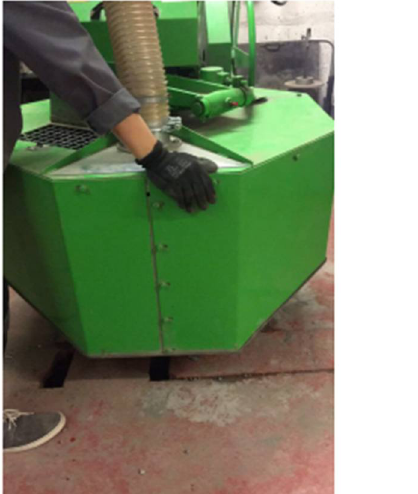
Figure 5. Concrete mixer ( left ); concrete slump test ( right ).